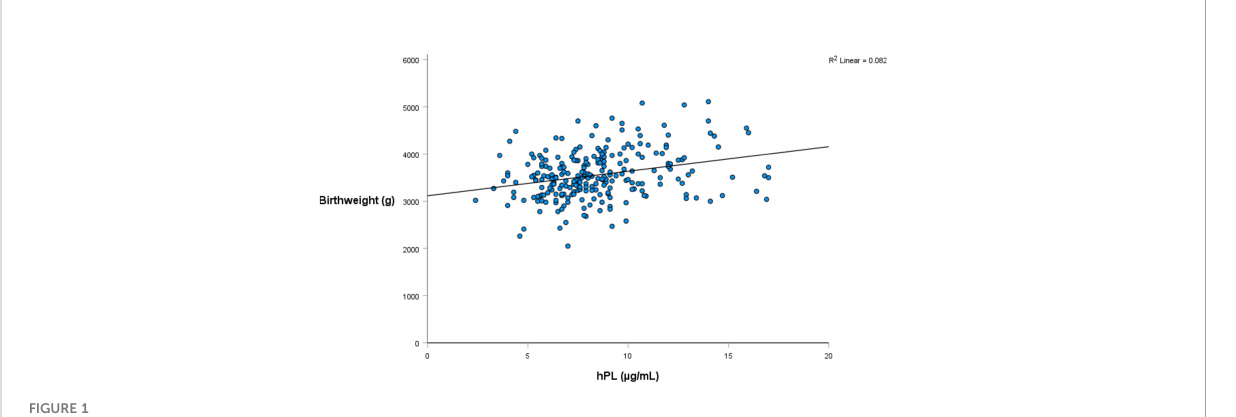
FIGURE 1 The relationship between hPL (µg/mL) and infant birthweight